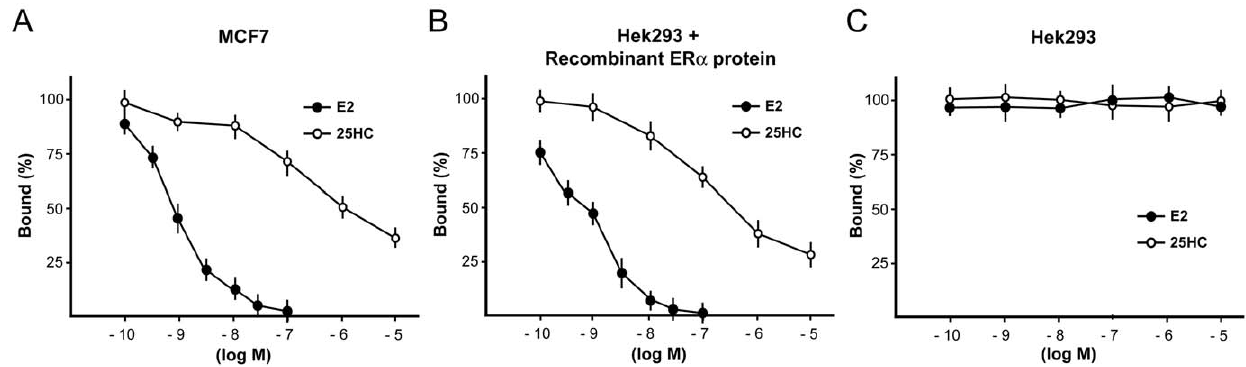
Figure 2. ER a ligand binding assays. The graphs show residual binding of the radioactive tracer in the presence of increasing concentrations of unlabelled E2 and 25HC in MCF7 cells (A), in Hek293 cell lysates in the presence (B) or absence of recombinant ER a protein (C). Each data point represents the mean 6 SD of triplicate samples of three separate experiments. Note that the amount of tracer bound in the absence of competitor was arbitrarily set to 100% and that the underlying absolute values differ between the three